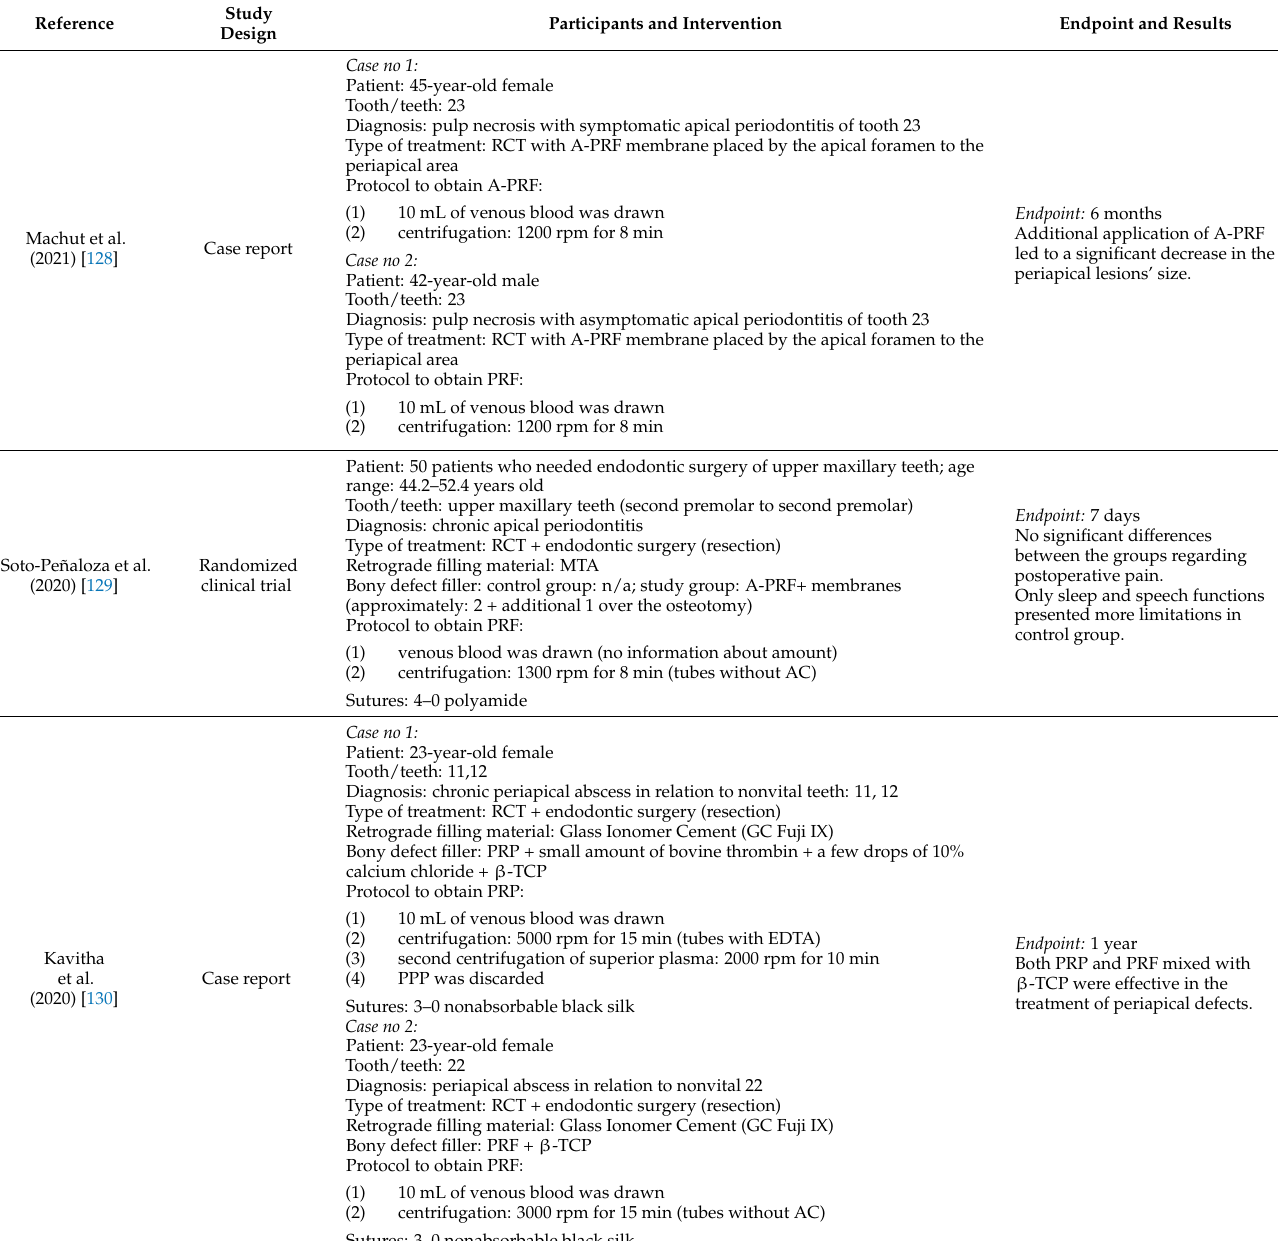
Table 3. PRF in the endodontic treatment of permanent teeth with closed apexes on the basis of the literature [128–141].